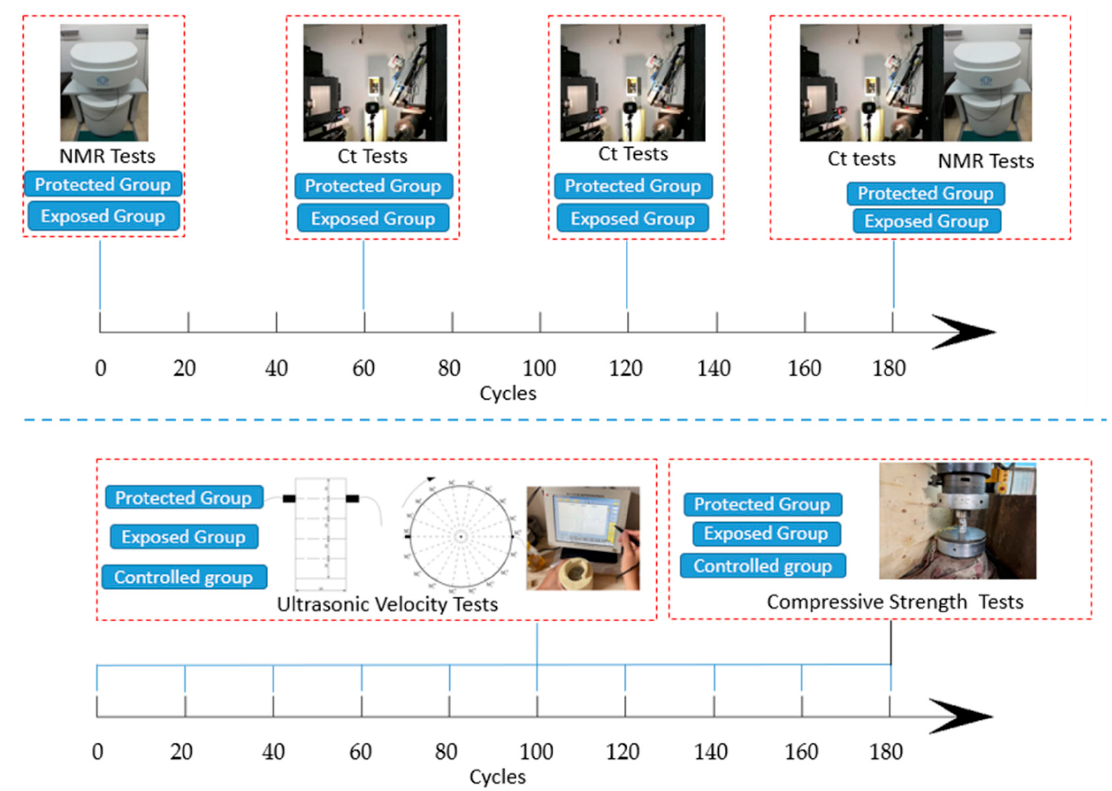
Figure 2. Overall test protocol of the experiment.